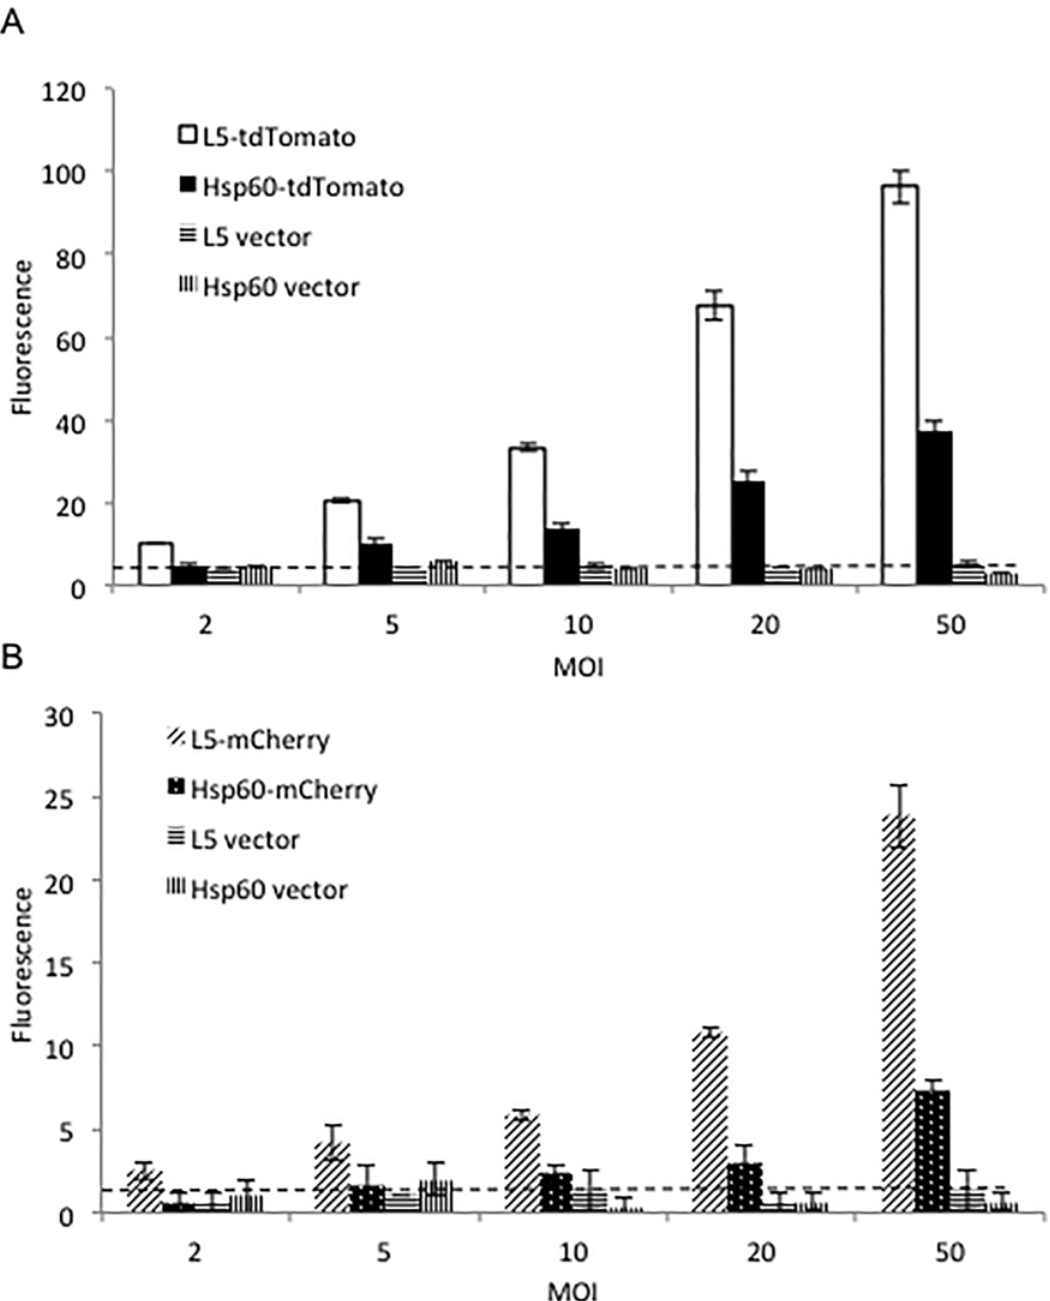
Fig 2. Comparison of strains expressing fluorescent proteins under L5 and Hsp60 promoter expression in infected cells. J774A.1 cells were infected with various multiplicities of infection (MOI) of the BCG strains expressing L5-tdTomato or Hsp60-tdTomato (A); L5-mCherry or Hsp60-mCherry (B). Fluorescence was measured with a multimode reader with excitation wavelength 530 nm and emission wavelength 590 nm for tdTomato and excitation wavelength 570 nm and emission wavelength 620 nm for mCherry. Value in Y-axis represents mean of fluorescence of triplicates divided by their OD at 600 nm. The error bars are standard deviations. Dotted lines represent background fluorescence from strains carrying backbone vectors. Data represent one of at least three independent replicate experiments. bovis BCG strains with plasmids expressing tdTomato under L5 or Hsp60 promoter were com- pared with strains carrying the vector plasmids alone. OD values at 600 nm for each strain was